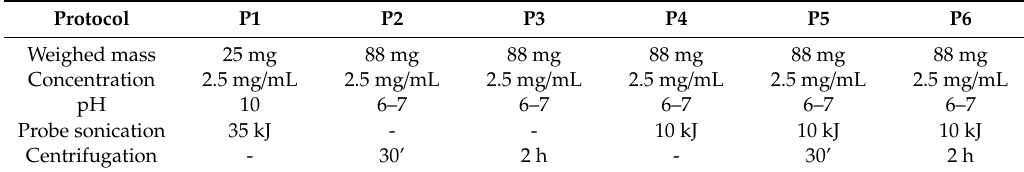
Table 2. Tested sample preparation protocols for TEM analysis of the E171